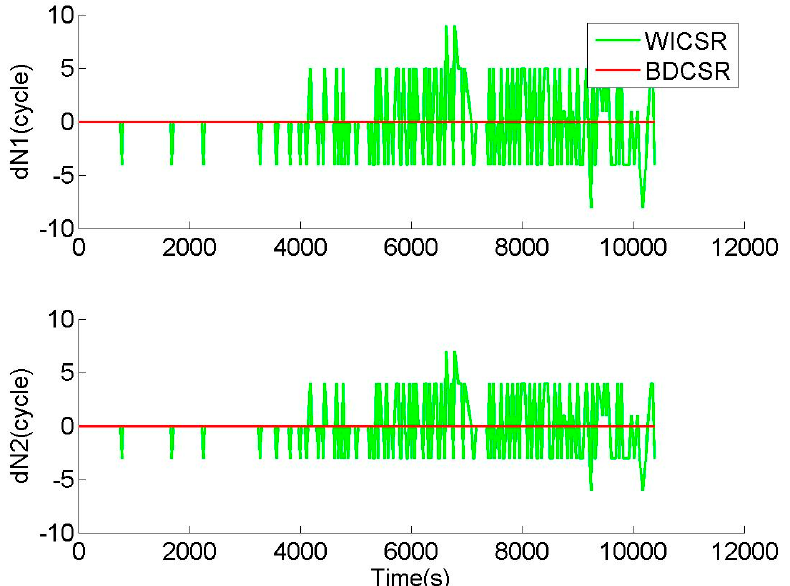
Figure 6. The original cycle slips of WICSR without correcting the ionospheric variations and those of the BDCSR methodology after correcting the ionospheric variations, where the BDS dual- frequency pseudoranges and phases without cycle slip were collected from the MEO Satellite 11 during the geomagnetic storm, started from UTC 8 May 2016 00:00:00 with an interval of 30 s at the CUT0 station.